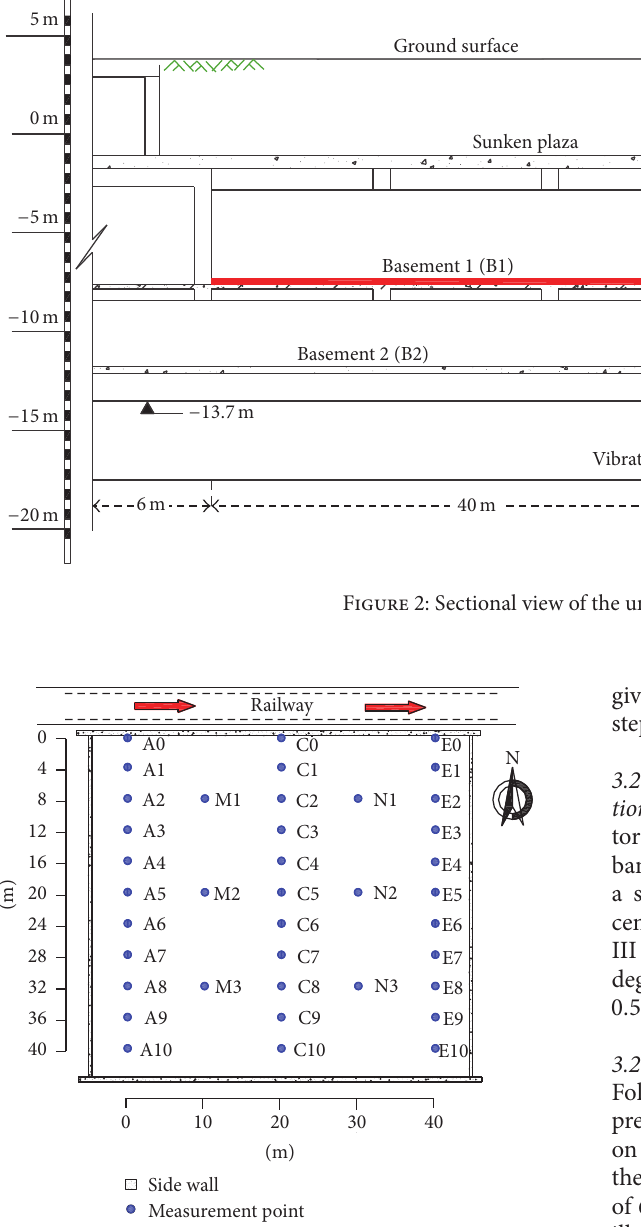
Figure 3: Arrangement of measurement